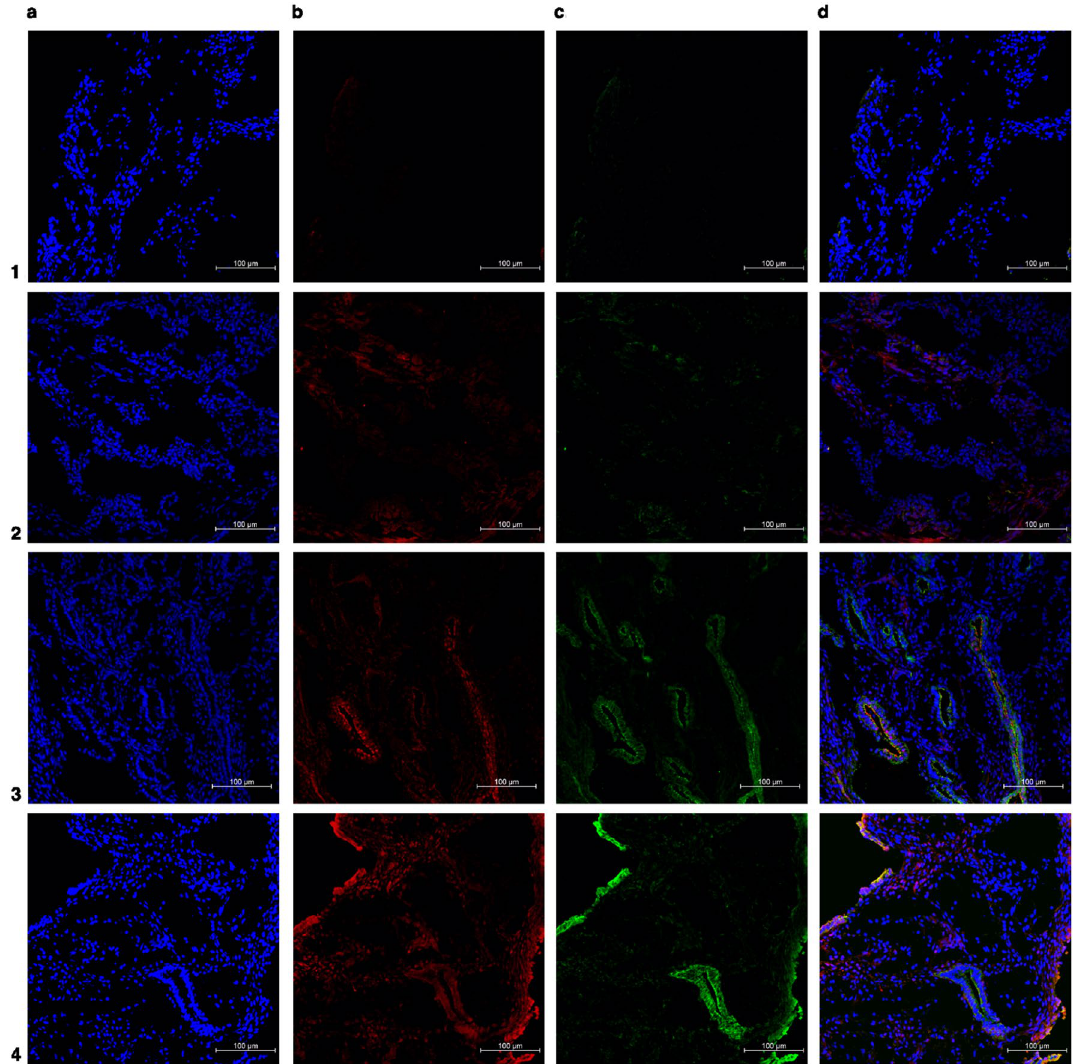
Figure 6. Representative immunofluorescence costained images of the endometrium in the non-endometriosis endometrium. ( a ) In blue: DAPI ( b ) in red: senescent associated biomarkers (p16 or lamin b1) ( c ) in green: anti-E-cadherin antibody (epithelial glandular cells). ( d ) merged. Number 1 row represents negative control (endometrium of control group), number 2 row represents positive control (endometrial cancer or random ovary), number 3 row represents non-endometriosis endometrium labeled with p16, and number 4 row represents control group endometrium labeled with lamin b1. ×20